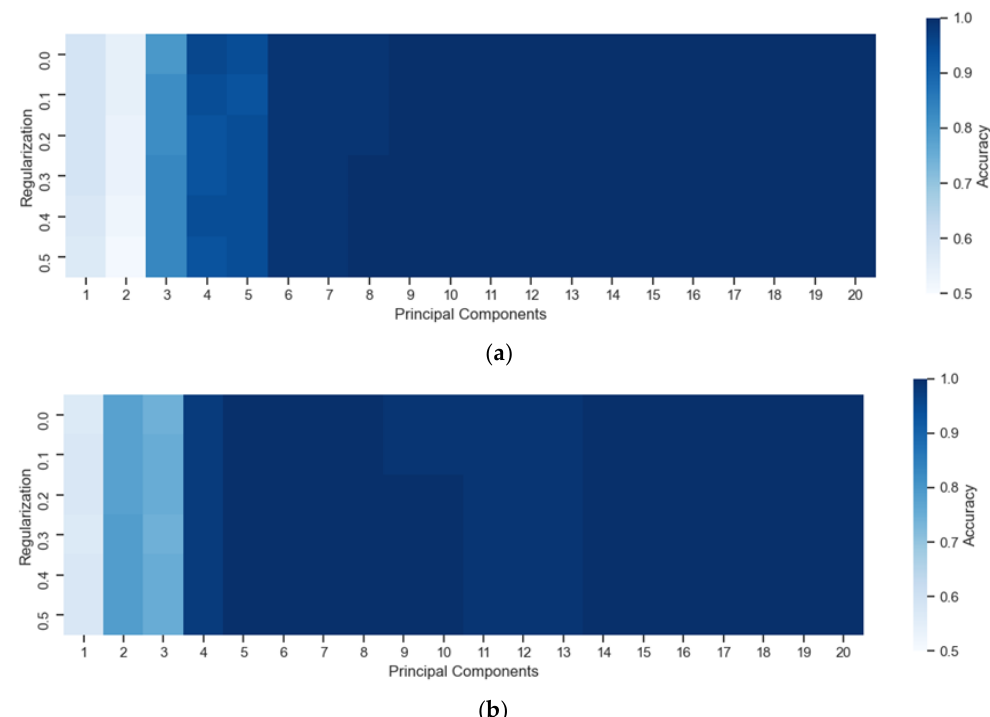
Figure 5. Optimization of the “ Principal Components ” and “ Regularization ” parameters in the ( a ) UV and ( b ) VIS region for the QDA algorithm.